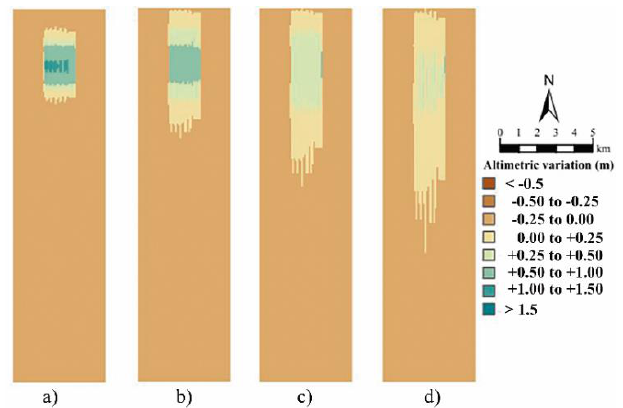
Figure 7. Beach nourishment impact on morphology after 5 years of simulation (θ = 60°; Ext/Ext) : ( a ) H= 1 m; ( b ) H = 2 m; ( c ) H = 3 m; ( d ) H = 4 m (based on [41,42]).